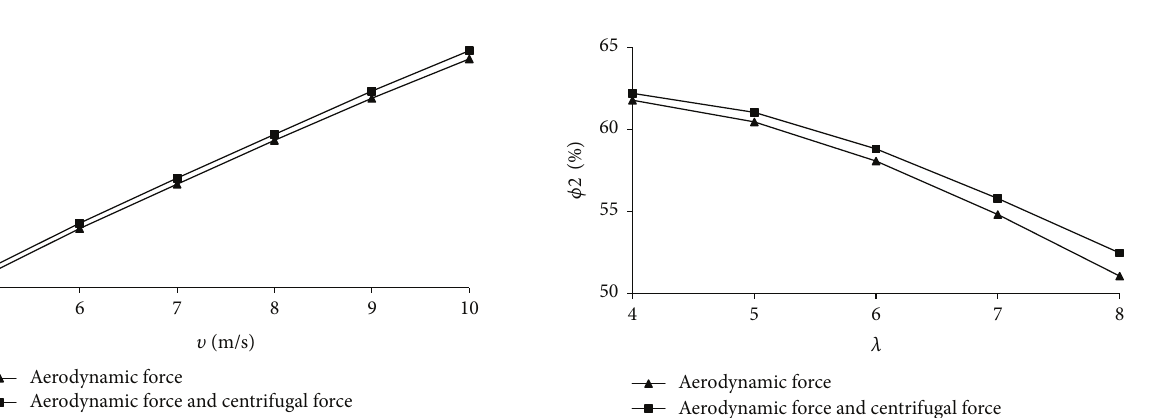
Figure 15: Variations of vibration frequencies of roundabout swing with working conditions defined by given wind velocity and varying tip speed